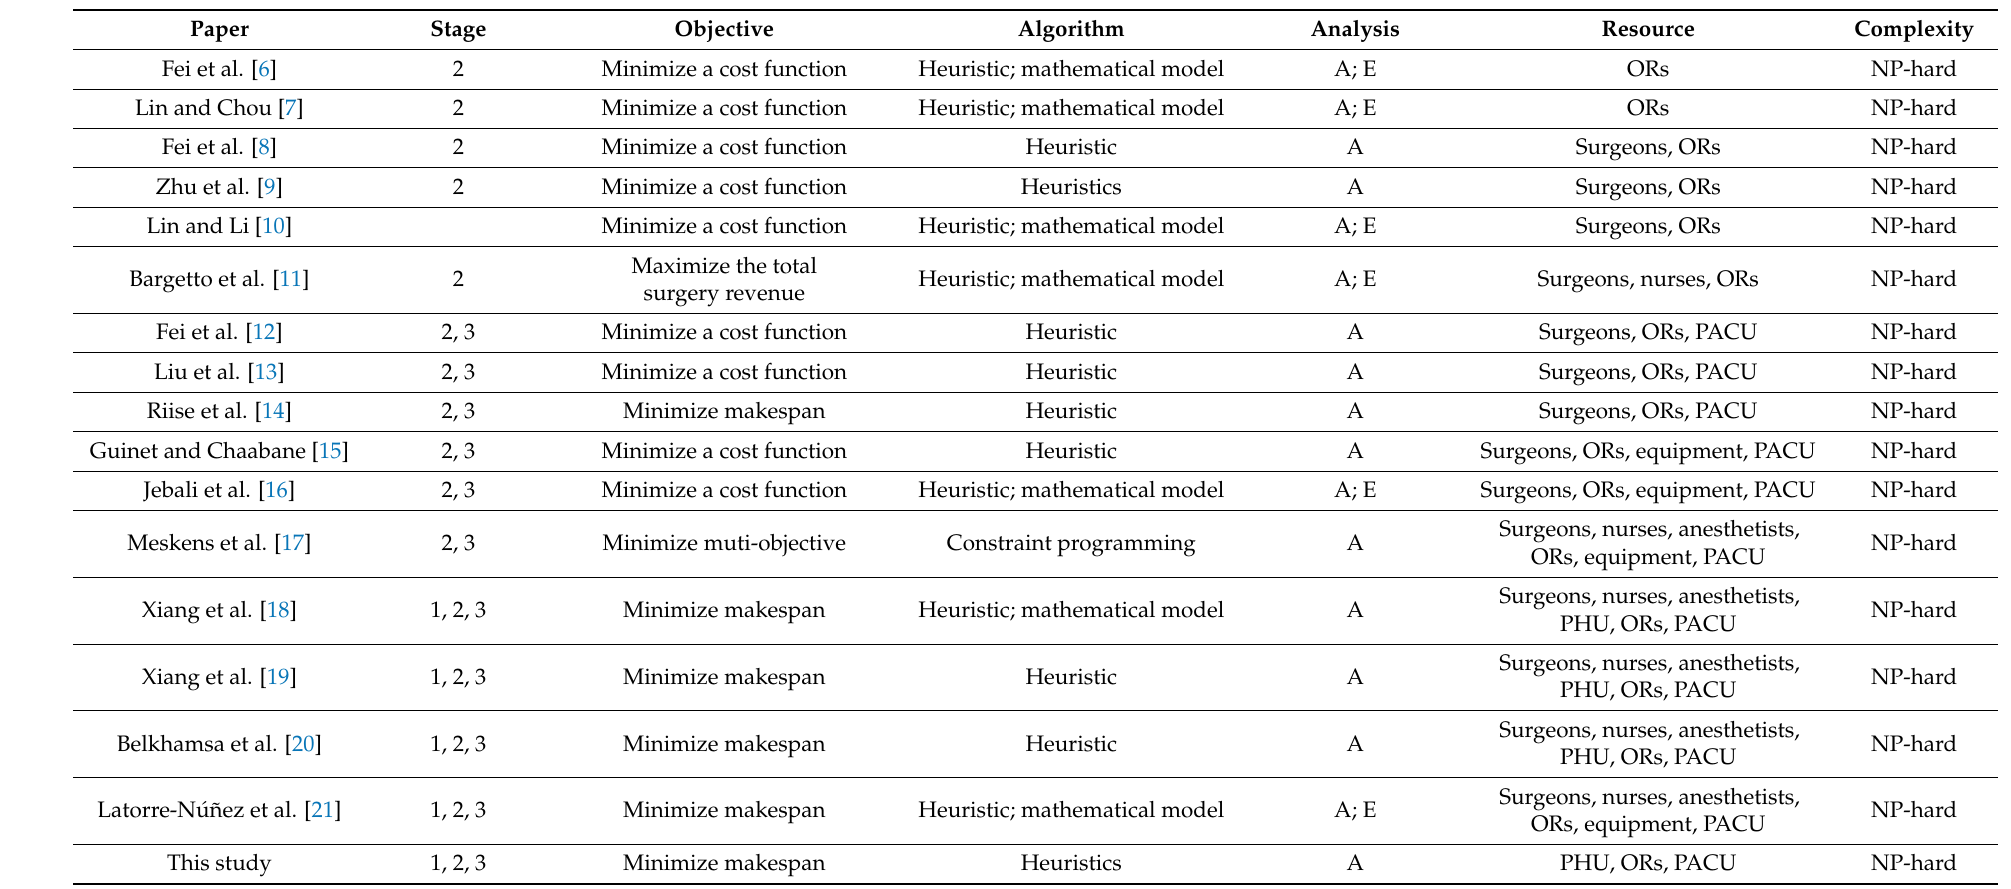
Table 1. Comparisons between key related work and this